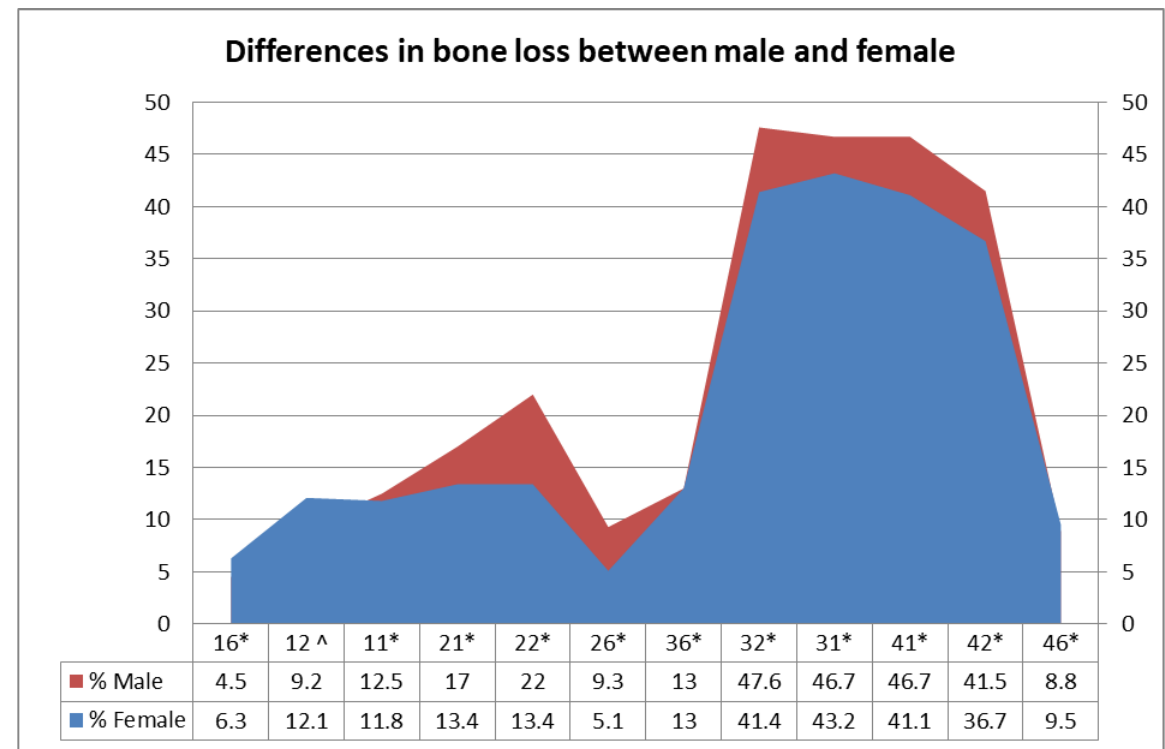
Figure 3. Percentages of bone loss among males and females. Mann–Whitney test: (*) indicates highly significant statistical differences; (^) indicates non-significant differences. Table 4. Significant values for the amount of bone loss among the age groups around the 1st molars and incisors—ANOVA